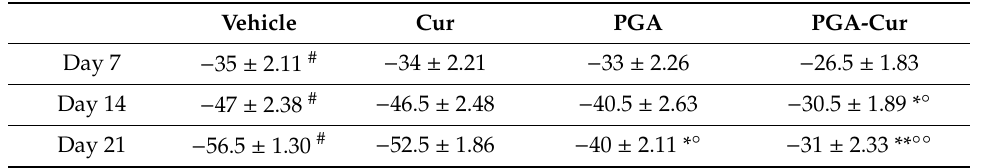
Table 3. The effect of the study compounds on locomotor deficit, measured as SFI (ranging from − 100 = total impairment to 0 = normal function, the latter being assumed in the control group). Values are expressed as mean ± standard error of the mean (N = 10/group).